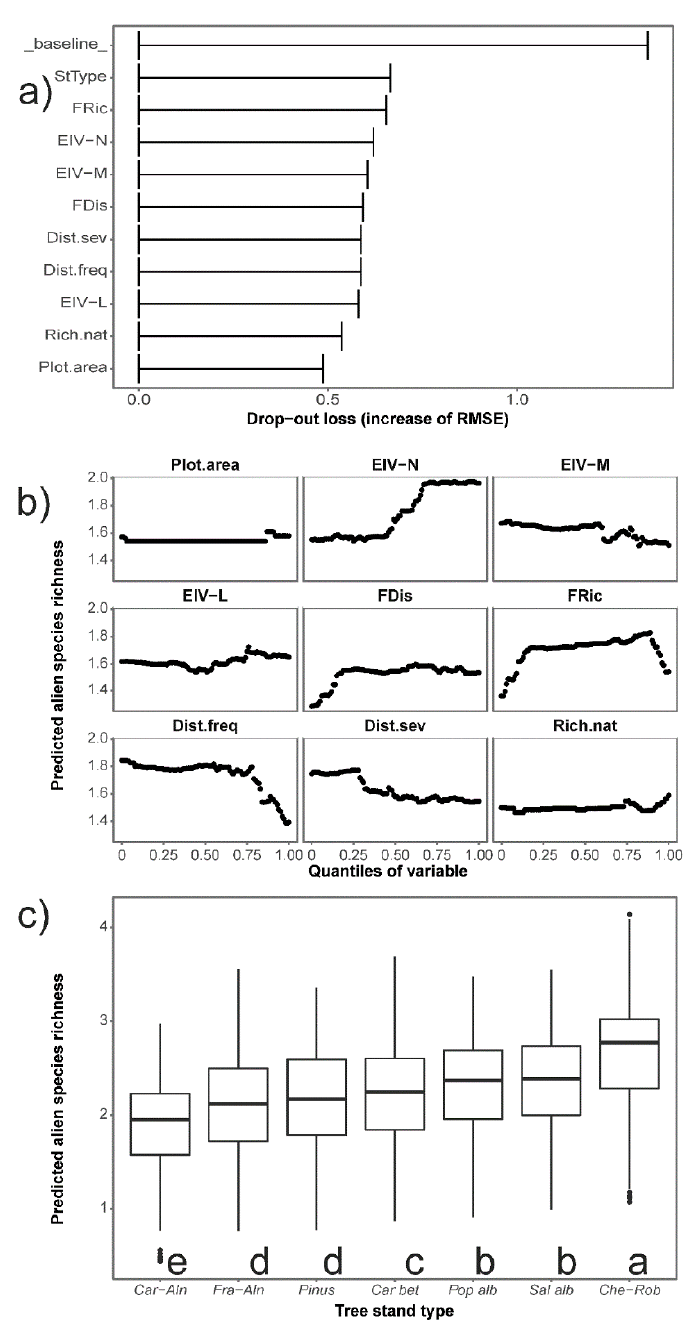
Figure 2. Alien species richness explained by a random forest model. ( a ) Importance of variables, expressed by drop-out loss in model RMSE when a particular variable is perturbed (baseline refers to permuted model responses, dashed line indicates value for the full model). ( b ) Partial dependence plots (ceteris paribus plots) showing changes of predictions when a particular predictor was changed while all remaining predictors were constant. ( c ) Partial group predictions for predicted alien species richness assuming constant levels of other predictors. Boxes represent interquartile range and median and whiskers represent minimum–maximum range in forest vegetation types: Car-Aln — Carici elongatae-Alnetum , Car bet — Carpinion betuli , Che-Rob — Chelidonio-Robinietum , Fra-Aln — Fraxino-Alnetum , Pinus —monocultures of Pinus sylvestris , Pop alb — Populetum albae , and Sal alb — Salicetum albae . For further details, see Tables S2 and S3. Vegetation types marked by the same letter did not differ statistically significantly in predicted alien species richness, according to the Tukey posteriori test at p = 0.05. According to data transformation, values were scaled into relative percentiles.